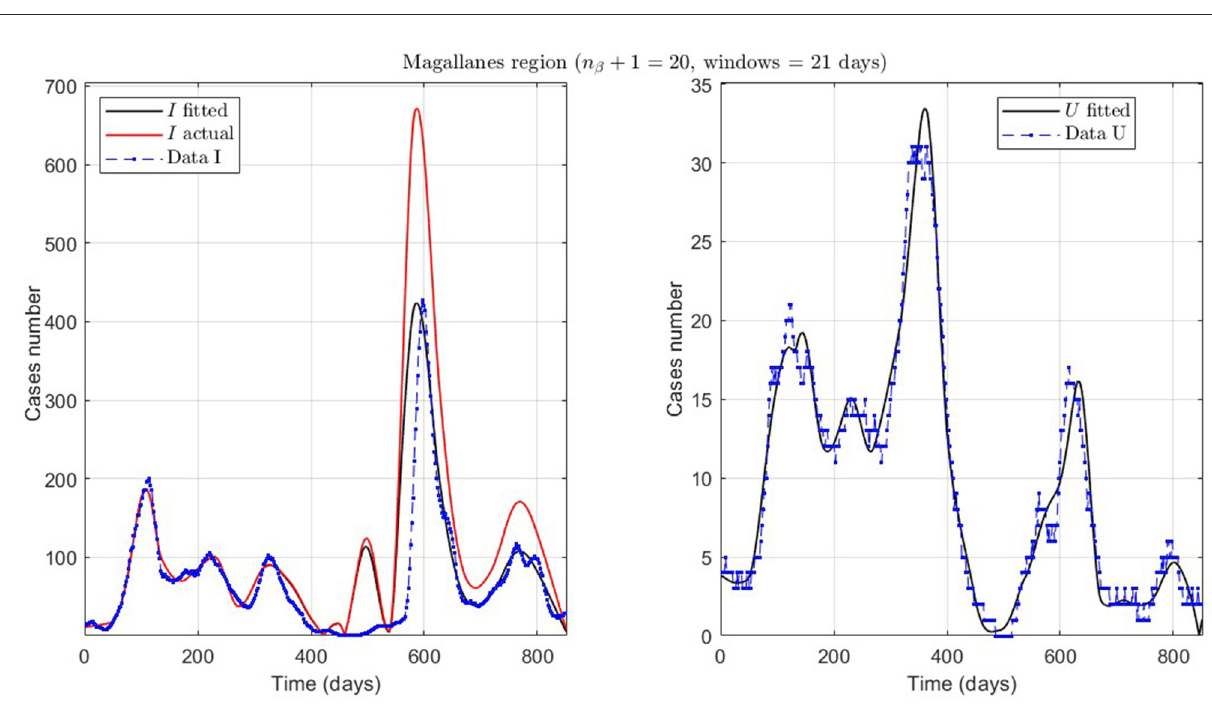
FIGURE9 Fitted incidence curves in the Magallanes region, Chile. 10 June 2020 to 8 October 2022; UB τ